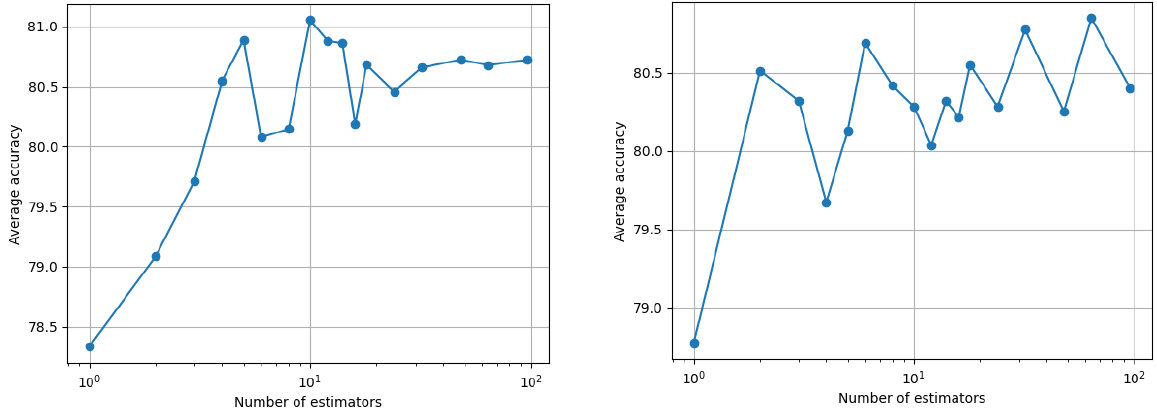
Figure 4. Balanced accuracy for the RF classifiers averaged over all four outcomes as a function of the number of estimators for one ( left ) and two months ( right ) memory.